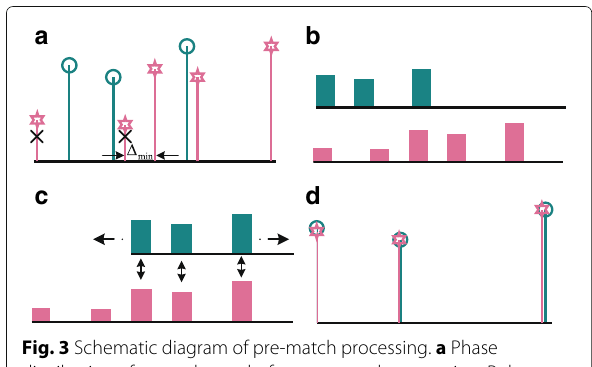
Fig. 3 Schematic diagram of pre-match processing. a Phase distribution of raw pole sets before pre-match processing. Poles marked with a cross denote the mismatched poles. b Quantified phase sequence of both raw pole sets. c Best match position. d Selected pole pairs with the minimum pole phase aligned